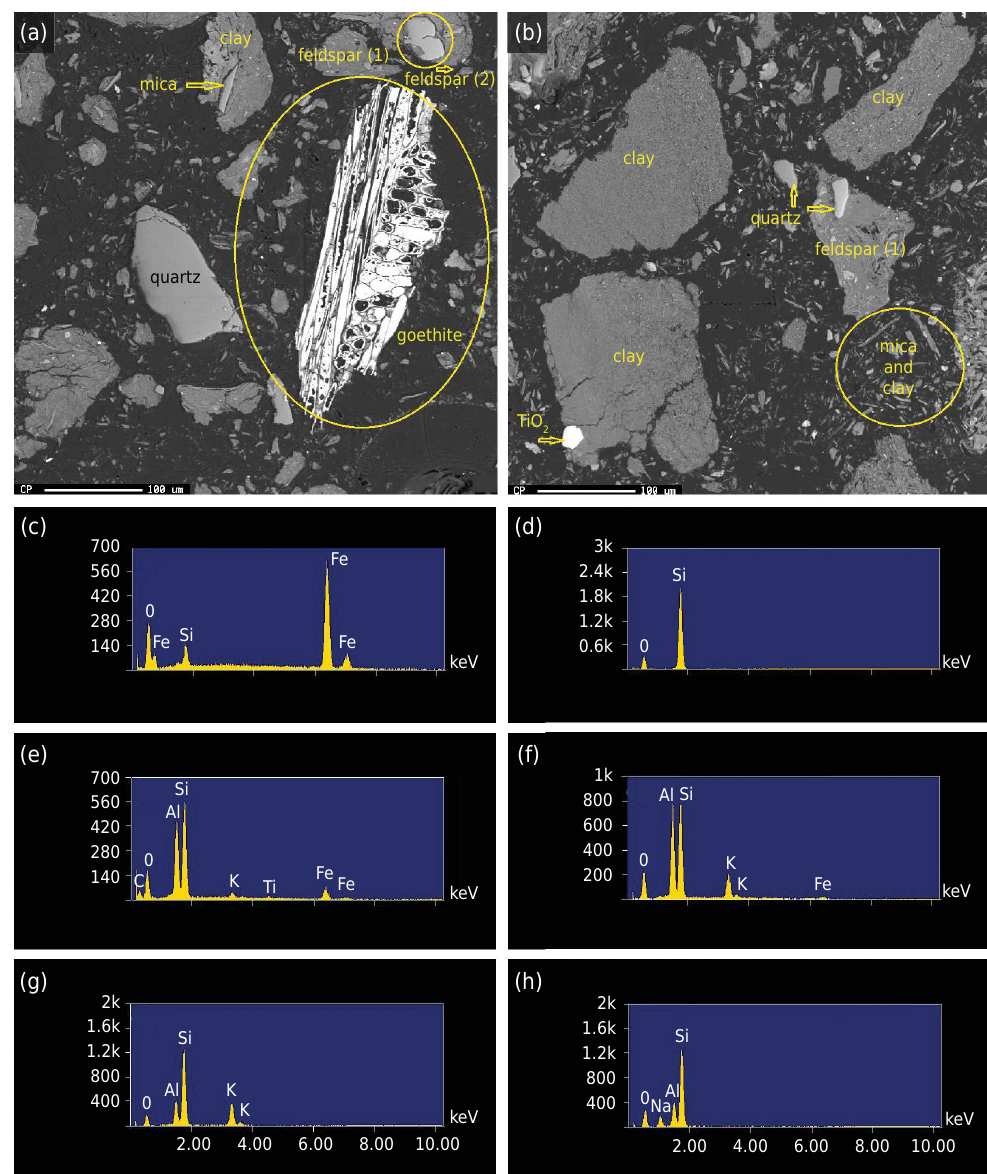
Figure 3. Microprobe scanning by backscattered electron emission for the unaltered Typic Rhodudult (a) and after 28 days of interaction with an alkaline solution (b).The EDX results on the goethite surface (c); EDX results on the quartz surface (d); results on the mica (muscovite?) surface (e); results on the clay (kaolinite?) surface (f); results on the feldspar 1 (microcline?) surface (g); and results on the feldspar 2 (albite?) surface (h). The images are representative of the whole